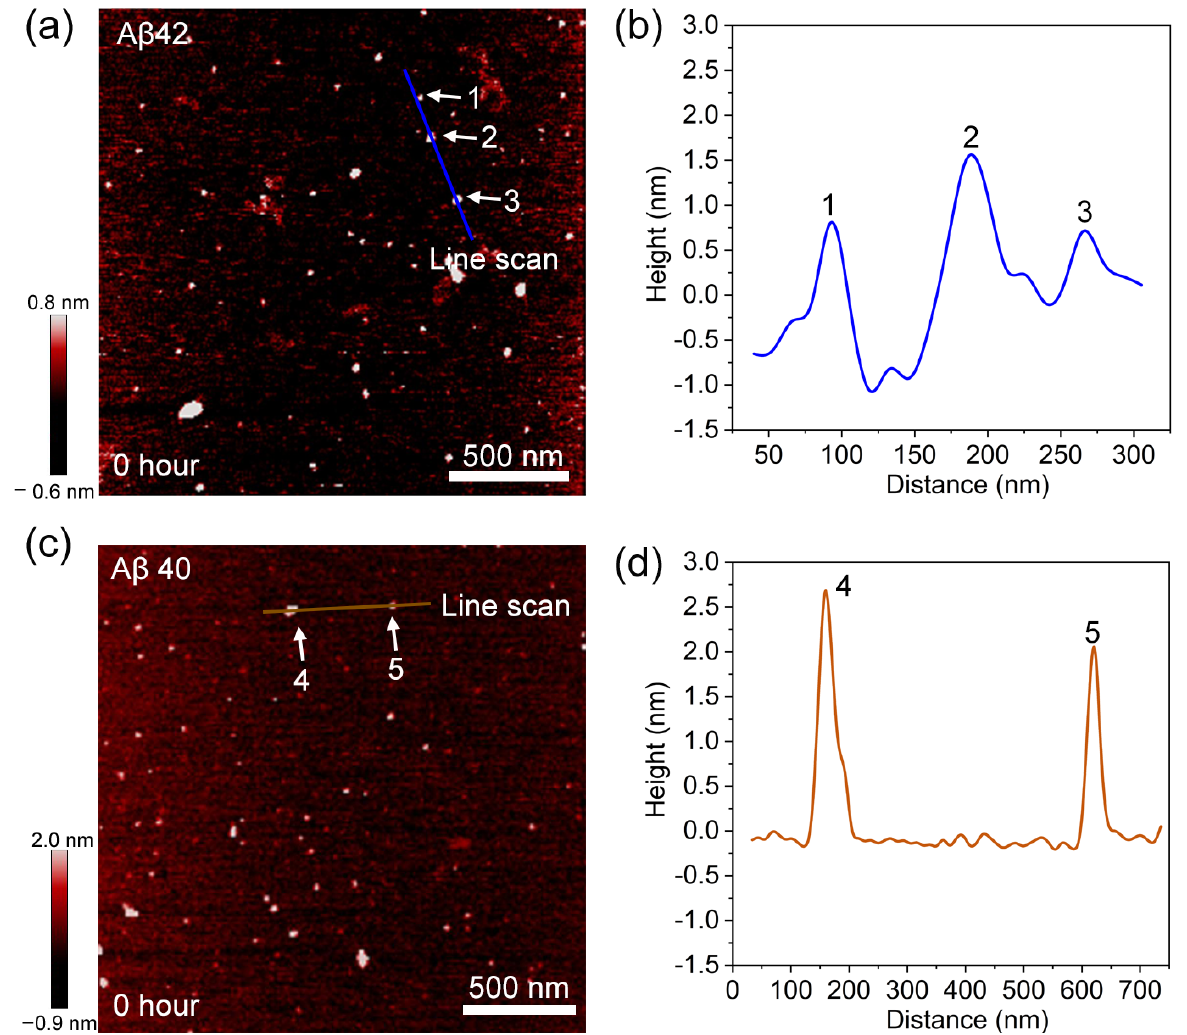
Figure 5. AFM images of oligomers and their height profile. (a) AFM image of Aβ42 oligomers. (b) Height profile taken along the blue line in (a), clearly revealing the height of three different particles. (c) AFM image of Aβ40 oligomers. (d) Height profile corresponding to the brown line in (c) .